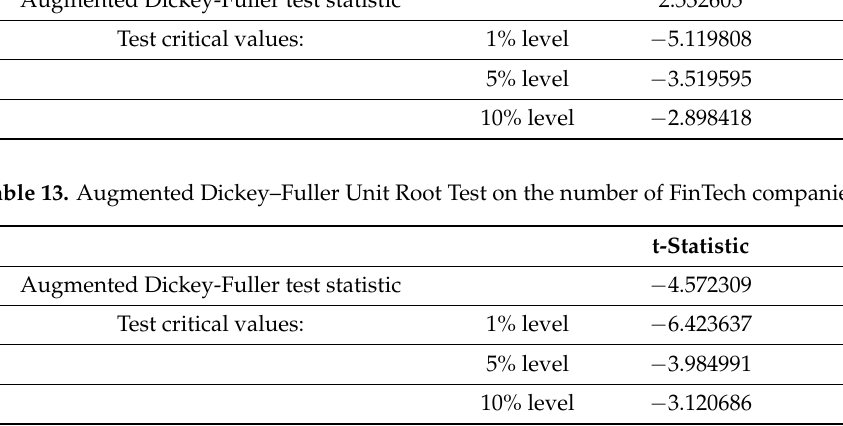
Table 13 results showed that 1st difference data of FinTech companies were stationary.